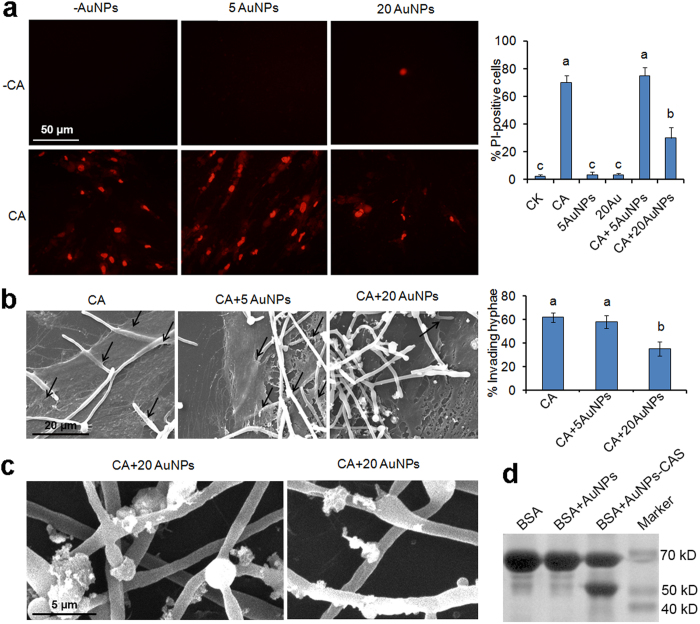
Attenuated C. albicans virulence and invasion to DPSCs when co-incubation with AuNPs.(a) DPSCs damage after 5 ppm AuNPs (5AuNPs), 20 ppm AuNPs (20AuNPs) alone (−CA) or co-incubated with C. albicans cells (CA). The DPSCs after 24 h of treatment were stained with PI and observed by fluorescence microscopy. Columns on the right indicate the statistical results of the percentage of PI-positive DPSCs. (b) SEM observation of fungal cells invading into DPSCs when co-incubated with 5 ppm AuNPs (CA + 5AuNPs) or 20 ppm AuNPs (CA + 20AuNPs) or wihout AuNPs (CA). Columns on the right indicate the statistical results of the percentage of invading hyphal cells. (c) SEM observation of fungal cells adhered by AuNPs. The fungal cells were co-incubated with DPSCs and 20 ppm AuNPs for 24 h and then observed. The error bars indicate one standard deviations (n = 3). Identical letters indicate no statistical differences among treatments (P < 0.05). (d) BSA degradation by AuNPs after adsorption of C. albicans culture suspensions. The fungal cells were cultured in BSA medium for induction of protease secretion, then the supernatant containing secreted proteases was obtained. AuNPs were incubated with the supernatants for 24 h, obtaining AuNPs adsorbing secreted proteases (AuNPs-CAS). AuNPs and AuNPs-CAS were added into fresh BSA medium and incubated for 12 h. BSA and its degradation products in the supernatants were then detected by SDS-PAGE and Coomassie Blue staining.